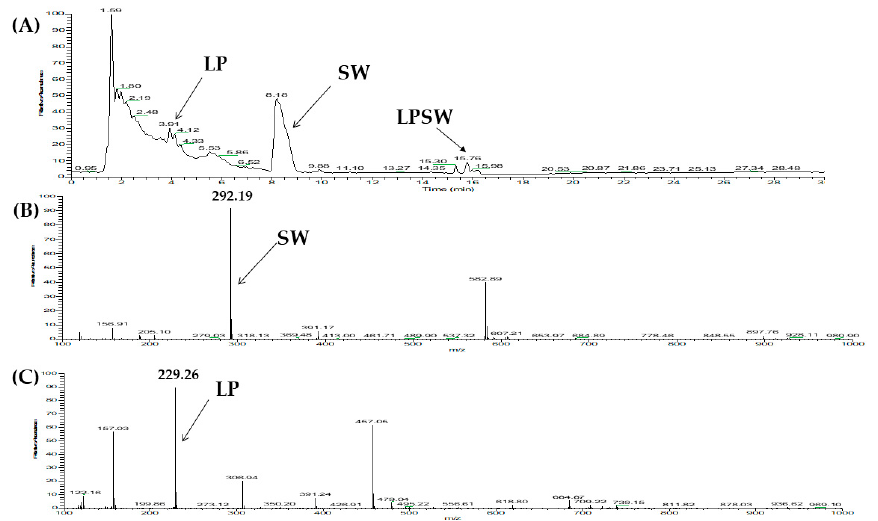
Figure 4. LC-MS chromatogram of ( A ) LPSW ( m / z 502) pre-incubated with DPP-IV for 3 h at 37 °C. ( B ) MS spectra of SW fragment ( m / z 292.12), and ( C ) LP fragment ( m / z 229.25). SW and LP were fragments derived from LPSW after 3 h pre-incubation with DPP-IV.